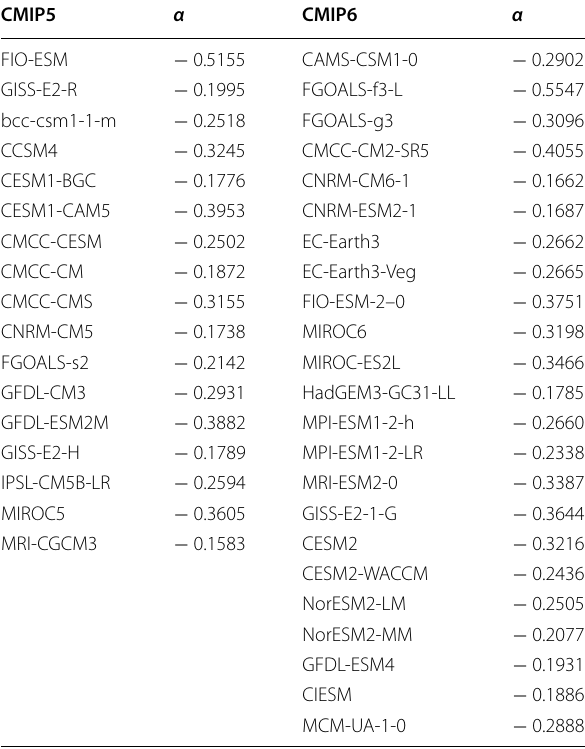
Table 1. 17 CMIP5 models and 23 CMIP6